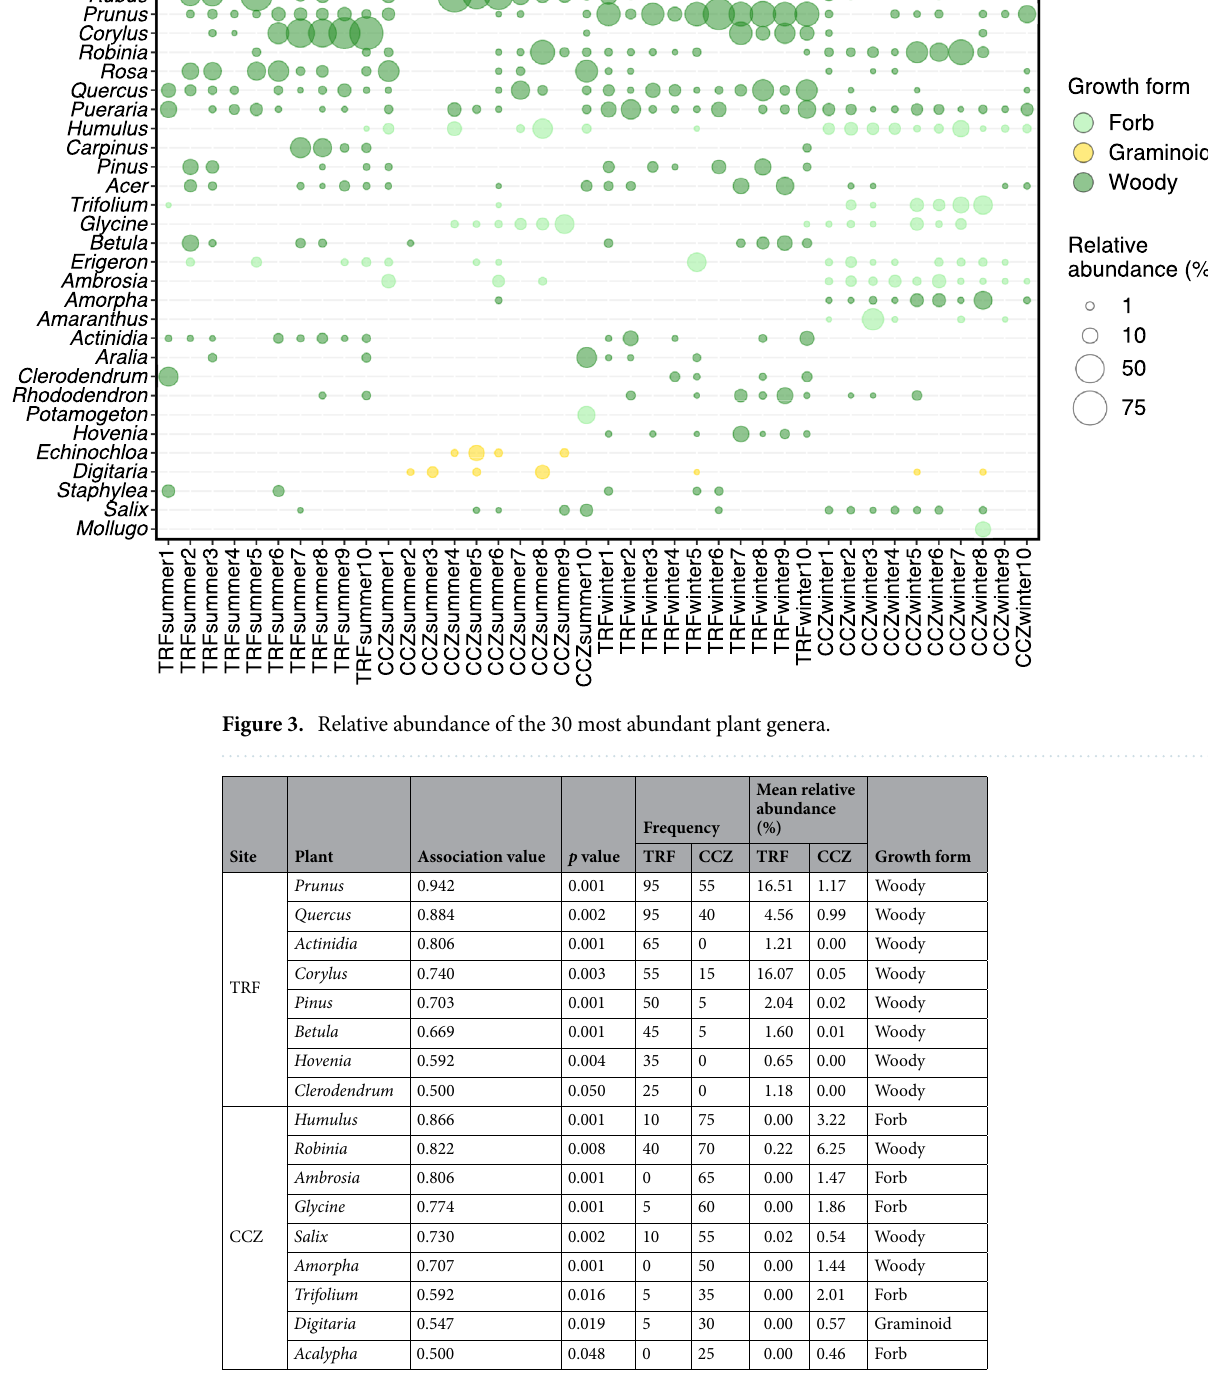
Table 1. Indicator plant genera identified in each